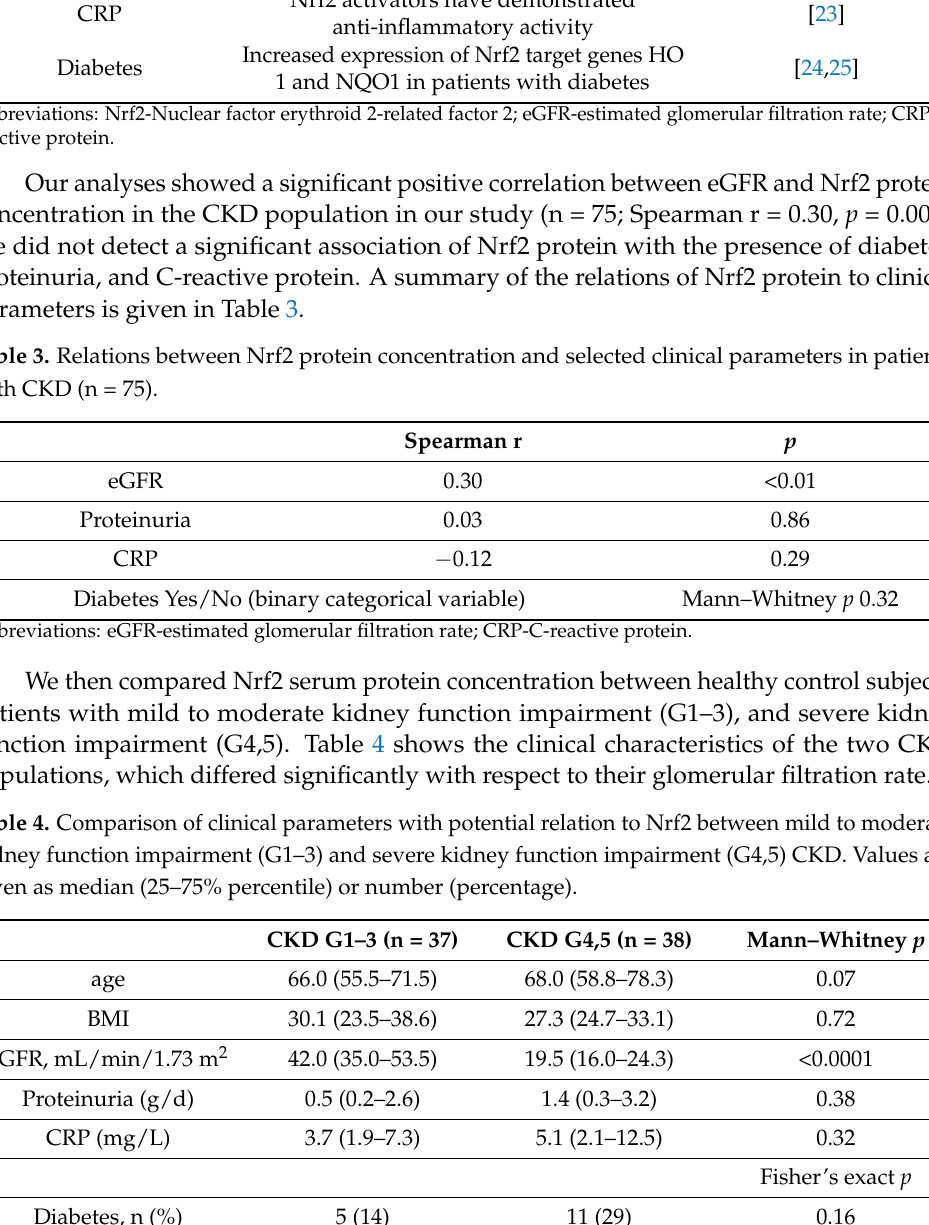
Impaired Nrf2 activity contributed to the eGFR Increased proteinuria in clinical studies with Proteinuria Nrf2 activators have demonstrated CRP Increased expression of Nrf2 target genes HO Diabetes 1 and NQO1 in patients with diabetes